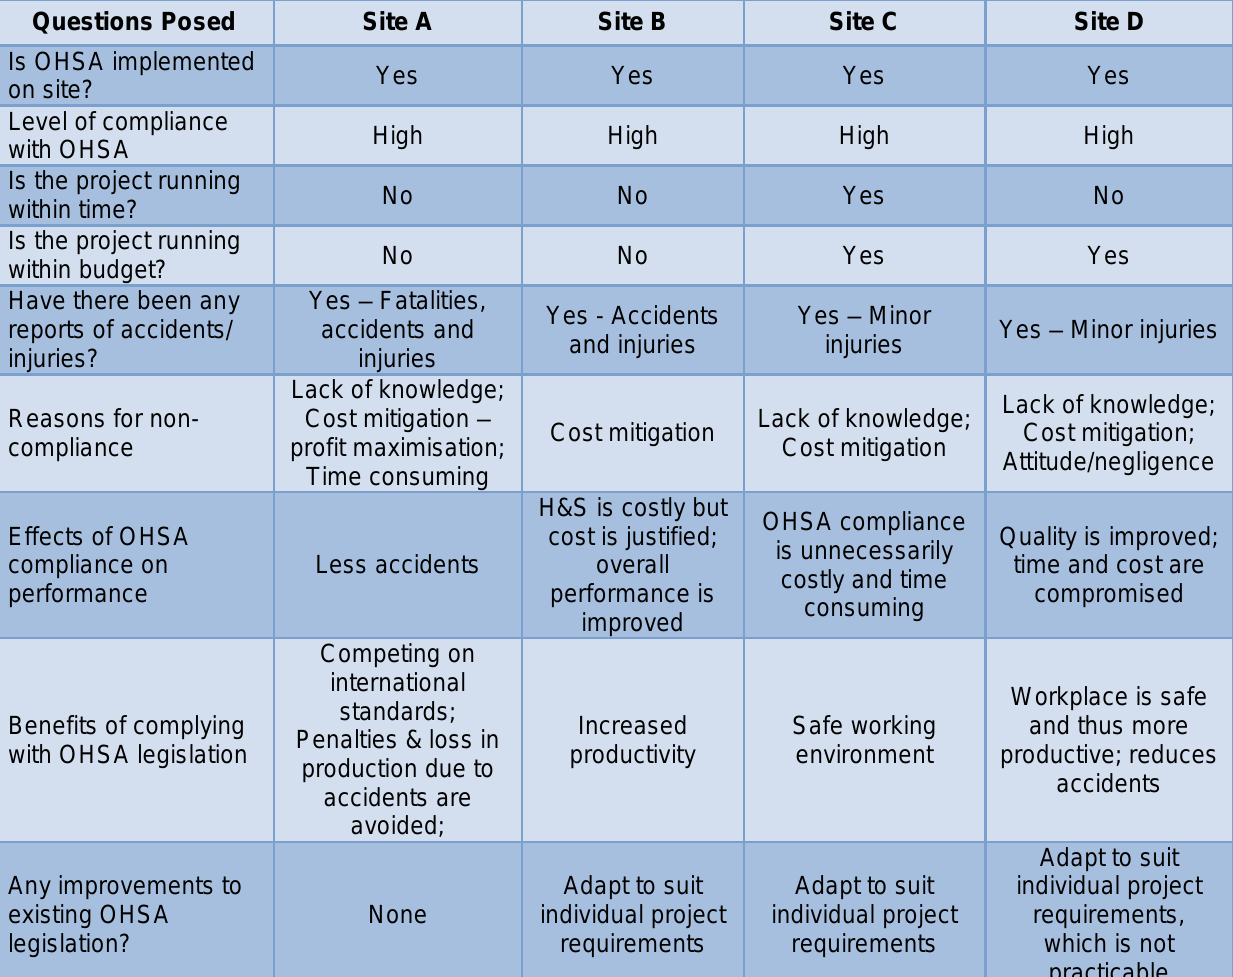
Table 6 Summaries of Case Study